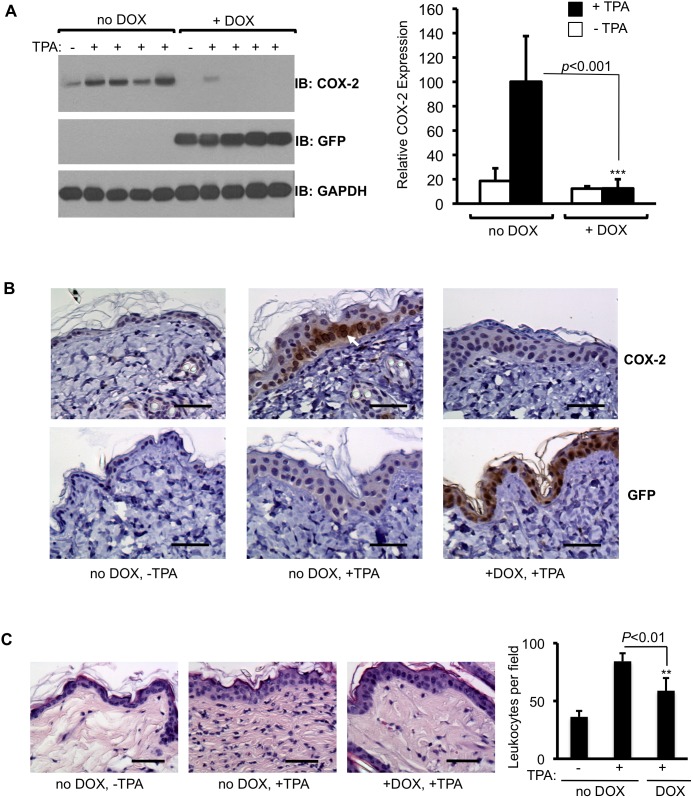
DOX-dependent suppression of TPA-induced COX-2 expression by shCox2 in mice homozygous for the Cox2 gene.(A) Double transgenic shCox2/C3 mice, which have two wild type Cox2 alleles, were maintained on either a control (no DOX) or a DOX-supplemented diet (+DOX) for 12 days, then painted with TPA on the back. 24 hours after TPA administration the mice were euthanized and skin extracts were assayed for GFP and COX-2 protein by Western blotting. Quantification is from three independent experiments. The COX-2 signal was normalized to the GAPDH loading control. Data are means +/− S.D. (***p<0.001). (B) COX-2 (upper panels) and GFP (lower panels) immunohistochemistry in skin of untreated shCox2/C3 mice (left panels), 24 hours after TPA administration to shCox2/C3 mice maintained on a DOX-free diet (center panels) and 24 hours after TPA treatment of shCox2/C3 mice maintained for 12 days on a DOX-supplemented diet (right panels). COX-2 staining is visible as brown patches (white arrow) in the basal epithelium. (C) H&E stain to visualize leukocytes in skin sections from double transgenic shCox2/C3 mice treated with TPA and/or DOX as in B. The graph depicts quantification of leukocytes in the dermis. Quantification is from two independent experiments. Data are means +/− S.D. (**p<0.01). The scale bar indicates 50 µm.